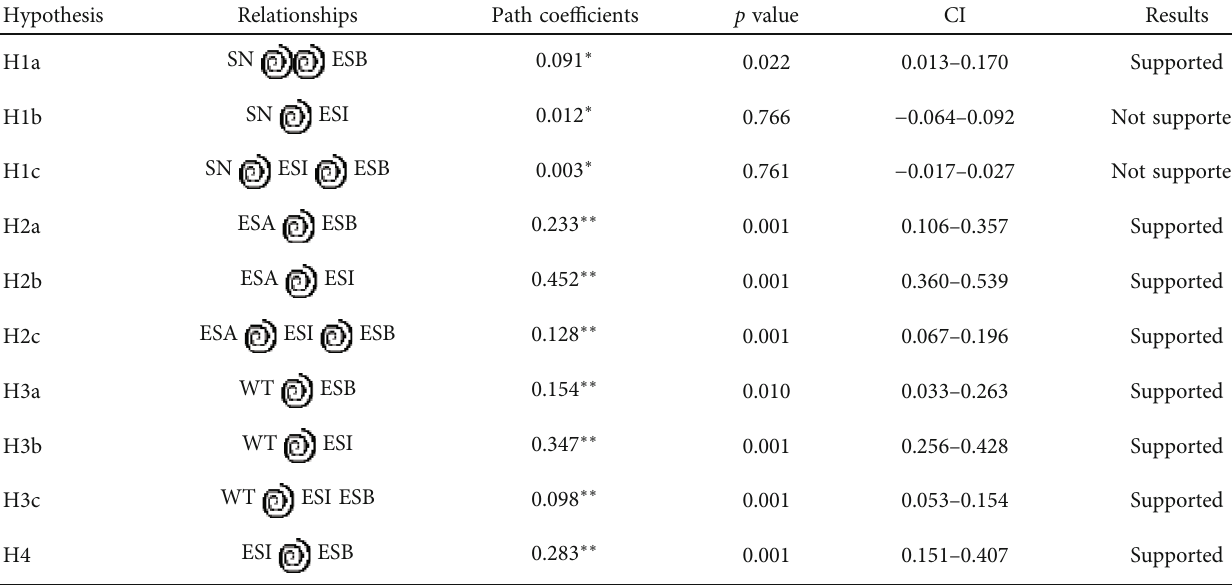
Table 11: Hypothesis testing result